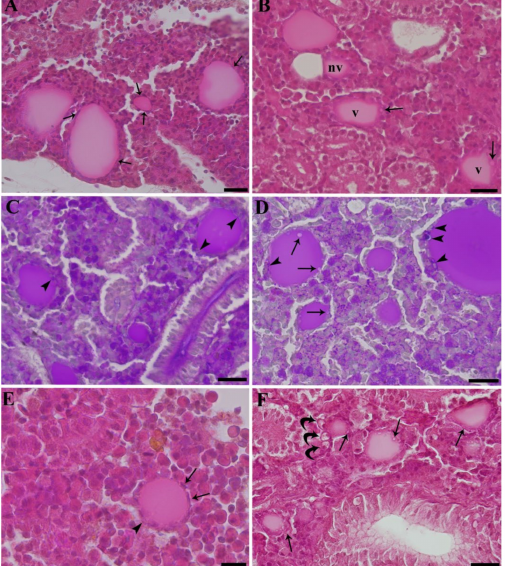
Figure 1. Paraffin-embedded tissue sections of carp kidney. H&E ( A , B , E , F ) and Alcian Blue-PAS ( C , D ). ( A ) Unexposed carp. Not vesiculated thyroid follicles. Flattened pavement cells are appreciable (arrows). Scale bar = 22 µ m. ( B ) Carp exposed to 2 mg L − 1 PFOA. Vesiculated (v) and not vesiculated thyroid follicles (nv) are visible in the same microscopic field. The former are lined by cuboidal cells displaying cytoplasm vesiculations (arrows). Scale bar = 22 µ m. ( C ) Unexposed carp. Not vesiculated thyroid follicles are lined by a flattened epithelium and show minute PAS positive inclusions (arrowheads), suggestive of endocytized colloid. Scale bar = 22 µ m. ( D ) Carp exposed